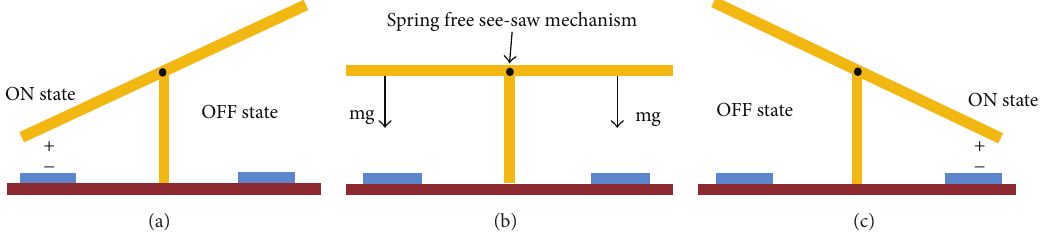
Figure 5: Schematic of different states of the bridge during the see-saw mechanism: (a) port 1 “ON” and port 2 “OFF,” (b) both “OFF,” and (c) port 1 “OFF” and port 2 “ON.”